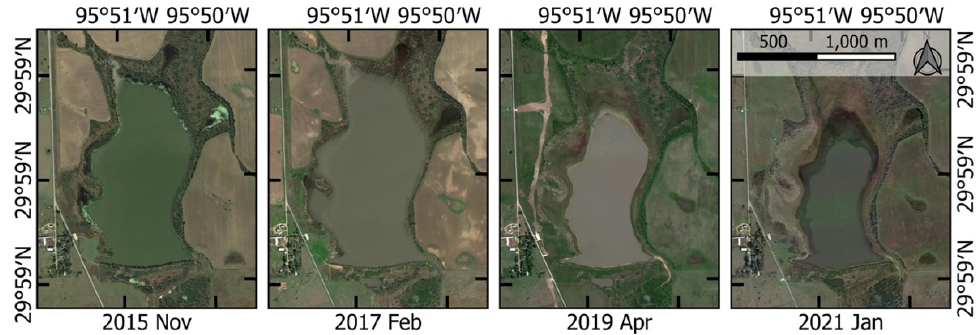
Figure 8. Time variation of wetland inundation area.